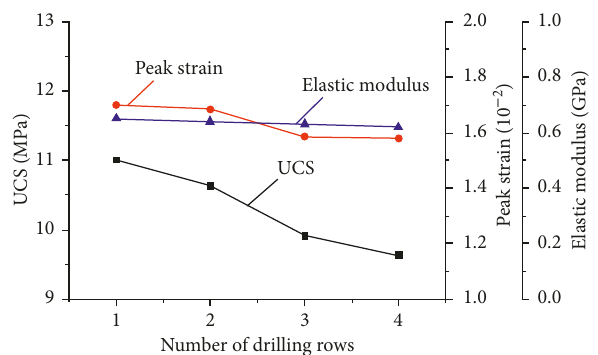
Figure 8: Influence of number of drilling rows on the mechanical properties of